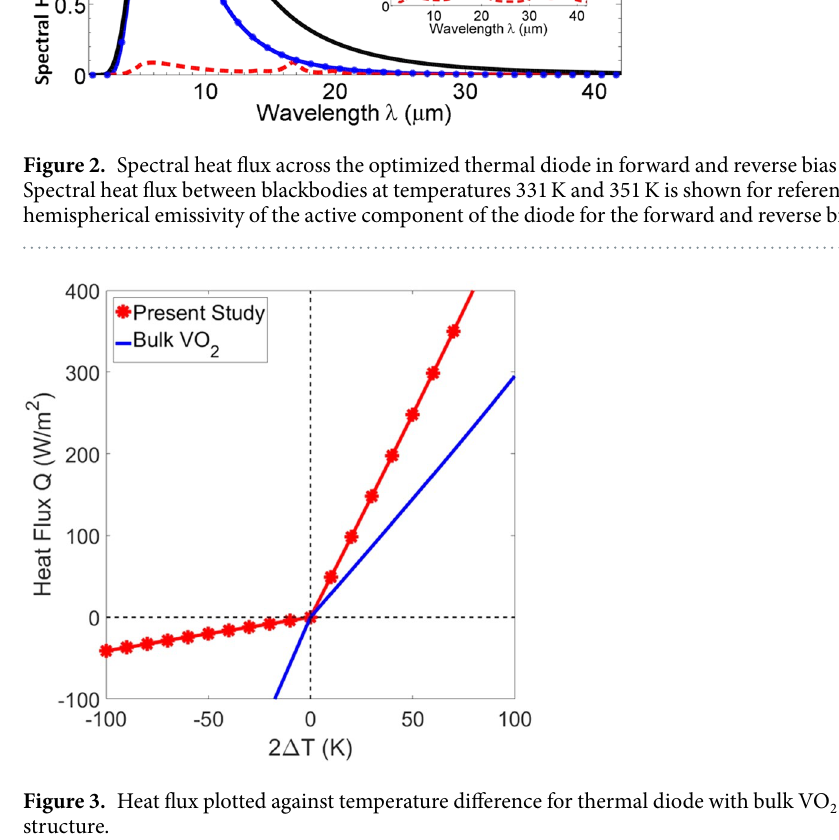
Fig. 2. A comparison is shown for heat flux across blackbodies at temperatures 331 K and 351 K, respectively. Inset in Fig. 2 displays angle-averaged emissivity of the active component in both scenarios. When VO 2 is metallic, the structure on the active component has high emissivity near the thermal wavelength ( λ th = 1.27 ħc / k B T = 8.5 μ m for 341 K). As a significant portion of blackbody radiation falls within this range, this gives rise to a high heat flux in forward bias. However, when VO 2 is insulating, the structure has very low emissivity in the broad spectrum. The tri-layer structure behaves like a highly reflecting mirror resulting in very low heat flux. Consequently, high contrast in heat flow is achieved leading to a high rectification ratio of 11.3 ( η = 0.918). In order to highlight the diode-like characteristics, heat flux across the device has been plotted against themeprature difference in Fig. 3. For comparison, simple case of bulk VO 2 is also shown, it has a rectification coeffcient of η = 0.49. Note that, effect of thermal hystersis is not considered here for simplicity. Angle dependent spectral reflectivity of the active com- ponent of the thermal diode is plotted in Fig. 4 for the forward and reverse bias cases. When VO 2 is metallic, the tri-layer structure acts like a wide-angle antireflection coating for wavelengths between 4 μ m to 10 μ m. The dark spot in Fig. 4 corresponds to Fabry-Perot type of resonance that occurs around λ = 4 n KBr ( λ ) L 2 = 5.3 μ m 47 . High absorption/emission in this wavelength region favors radiative heat transfer as thermal wavelength falls within this range. In reverse bias, the structure is highly reflective in a broad range of wavelengths giving rise to a very low absorption. Note that for thermal wavelength of 8.5 μ m, Fabry-Perot resonance occurs (for metallic VO 2 ) when thickness of KBr layer is L 2 = λ th /4 n KBr ( λ th ) = 1.4 μ m. This configuration however, would not necessarily achieve maximum rectification as the structure may not be purely reflecting when VO 2 is its insulating phase.